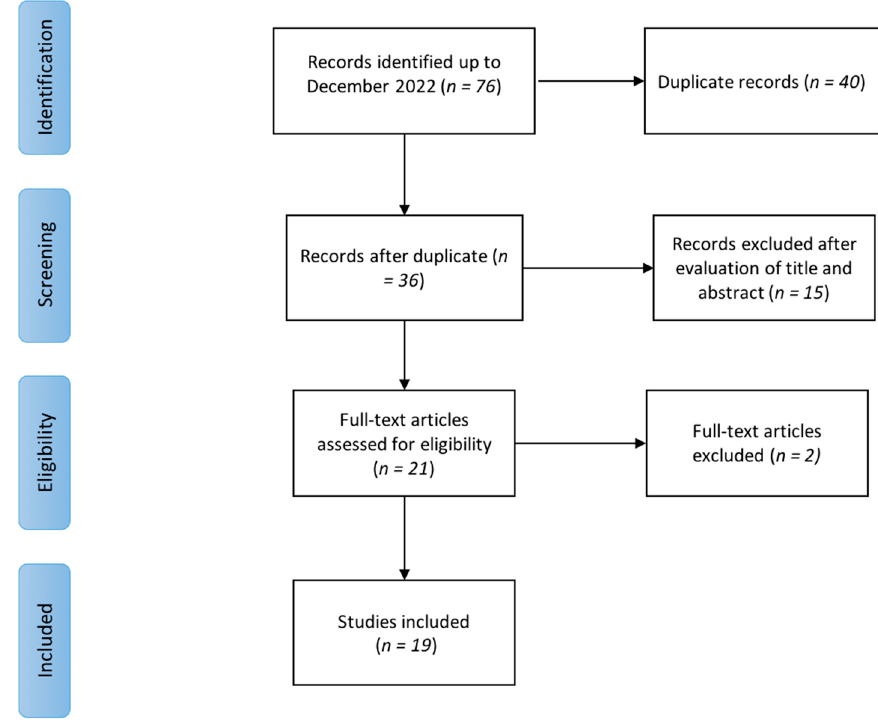
Figure 1. Flow diagram of the literature review process .